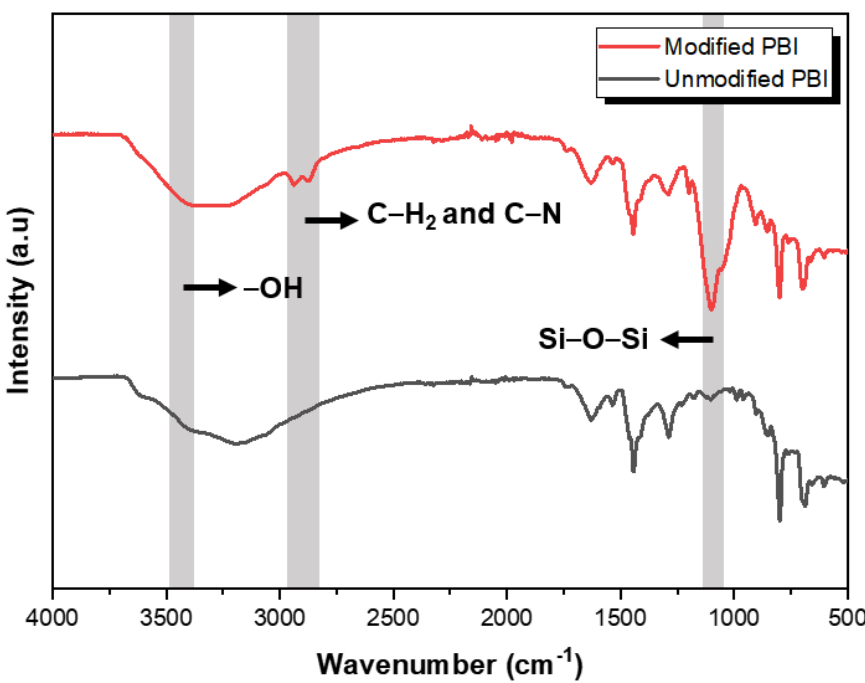
Figure 2. FTIR spectra of PBI membranes before and after crosslinking with GPTMS.